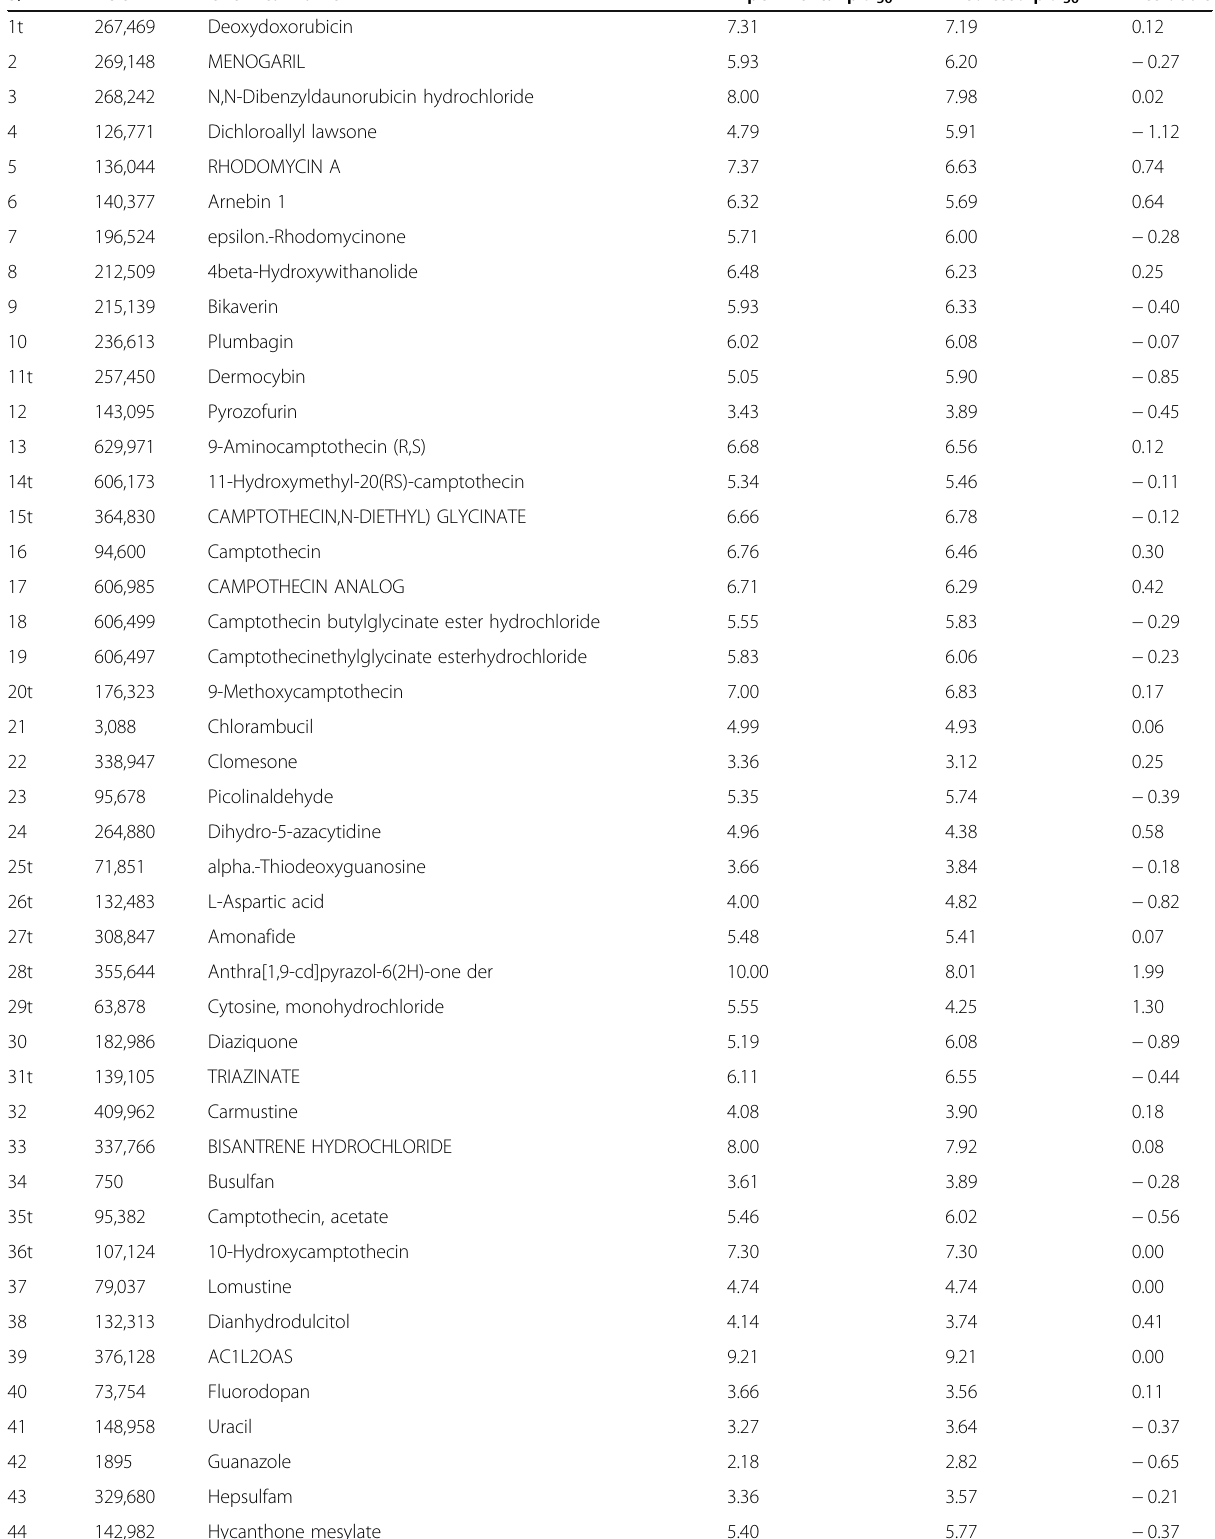
Table 1 NSC numbers, chemical names, experimental and predicted pGI 50 of the dataset with residuals